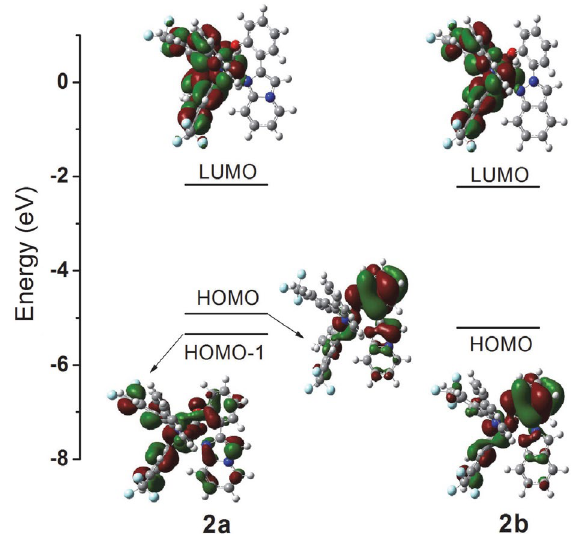
Fig. 4. The frontier molecular orbital diagrams of complexes 2a – 2b from DFT calculations.